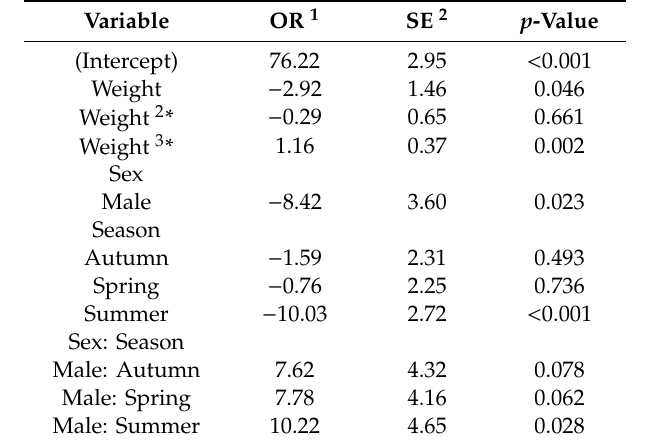
Table 4. Odds ratio and associated statistic of fixed e ff ects included in the final preference model of kennel cats.